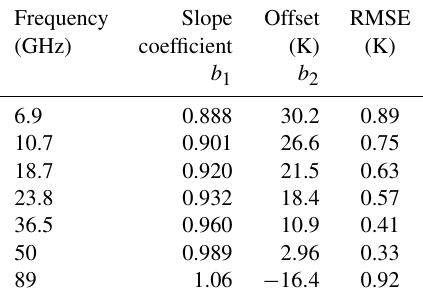
Table 2. Regressions of the T eff for different frequencies at vertical polarization as a function of the T Snow − Ice (see Eq. 7) using the MEMLS-simulated data